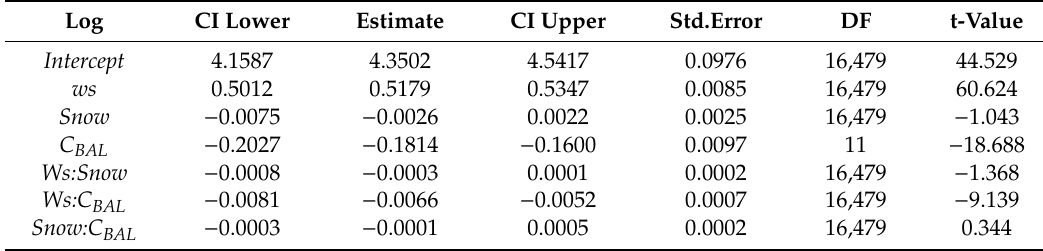
Table 4. Snow thickness model results.